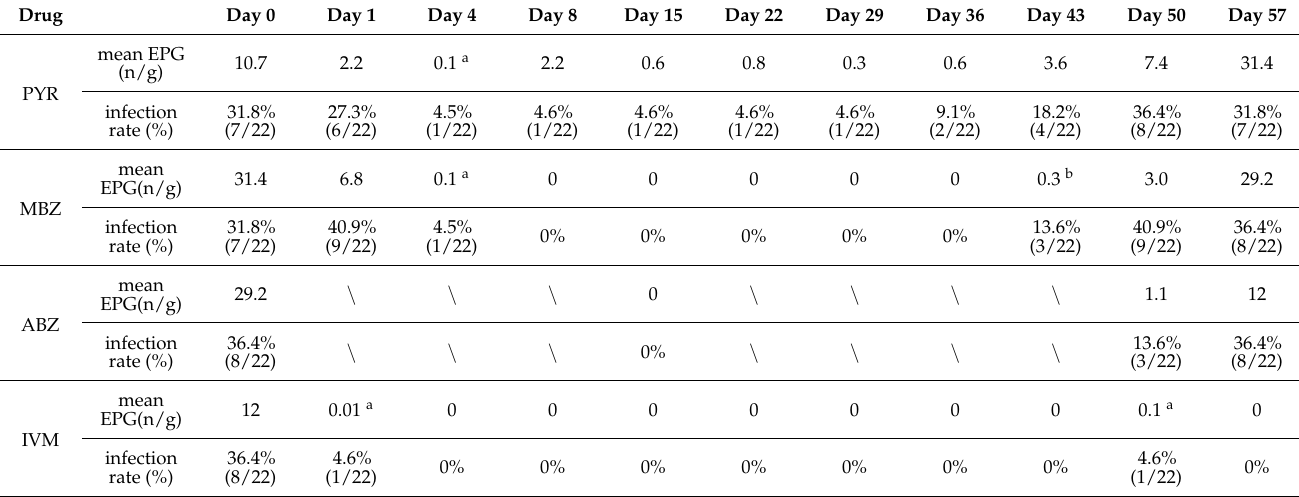
Table 2. The infective intensities and proportions of Baylisascaris schroederi before and after treatment with pyrantel pamoate (PYR), mebendazole (MBZ), albendazole (ABZ), or ivermectin (IVM) for the captive giant